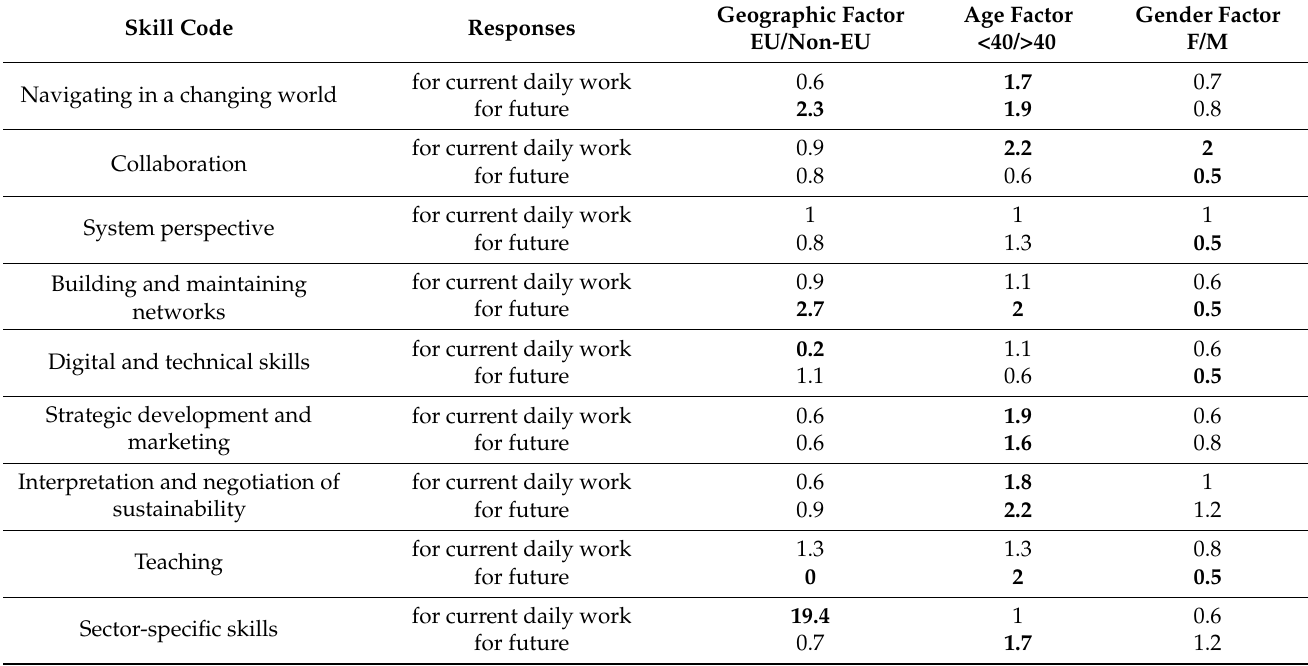
Table 4. Values of I for answers of FSA